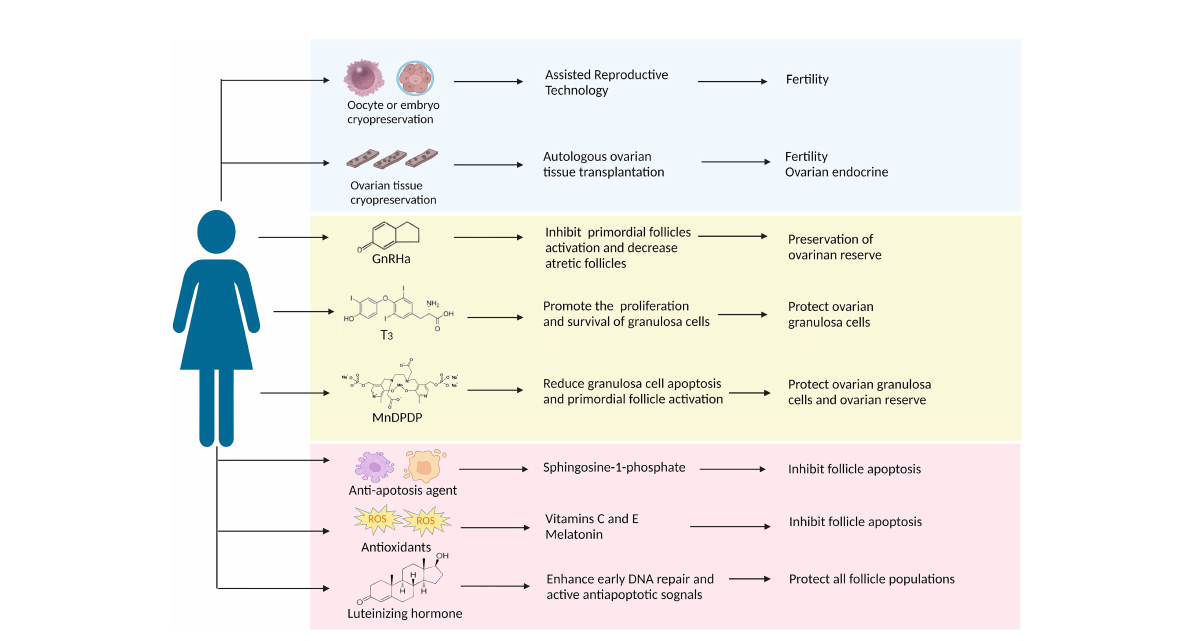
FIGURE 2 A summary of the protective strategies applied in clinical practice or have future potential against paclitaxel-induced ovarian damage. The approach discussed in this article is divided into three parts: the blue background box shows the methods that have been applied in clinical practice; the yellow background box shows potential strategies that have been proved to target taxane-induced ovarian damage in laboratory studies; the pink background box shows the potential strategies as presumed by the potential causative mechanism that can resist chemotherapeutic agents including